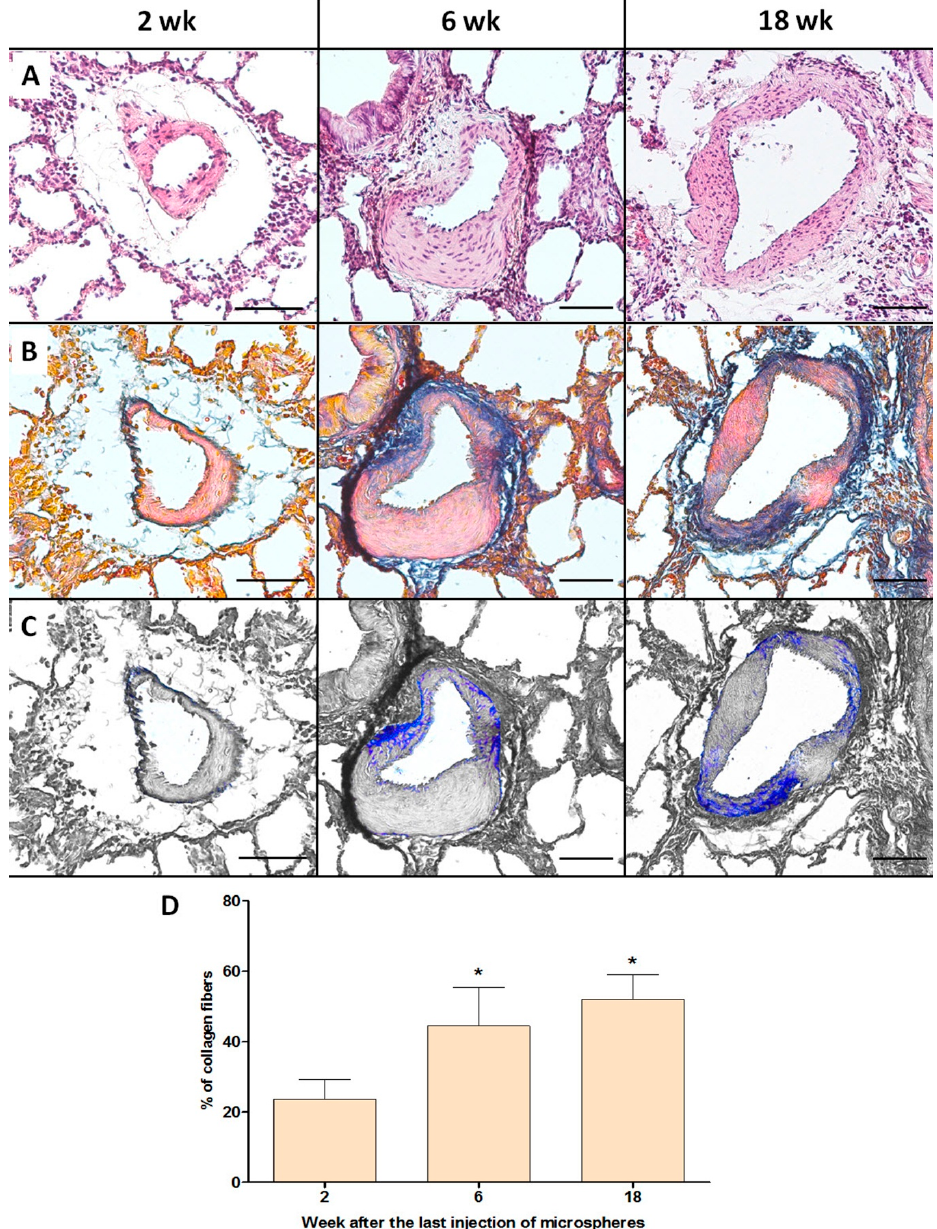
Figure 4 . Evaluation of fibrotic changes in the vascular wall of the pulmonary artery branches at different periods of CTEPH modeling. ( A – C ) Representative micrographs of vessels, scale bar = 50 μ m. ( A ) Haematoxylin–eosin staining. ( B ) Staining with Azan according to Heidenhain. ( C ) Monochrome isolation of collagen fibers in the structure of the vascular wall. ( D ) The percentage of collagen fibers in the vascular wall structure of the pulmonary artery branches. * p < 0.05 in comparison with the 2-week subgroup. n = 7 at each time point in CTEPH group.